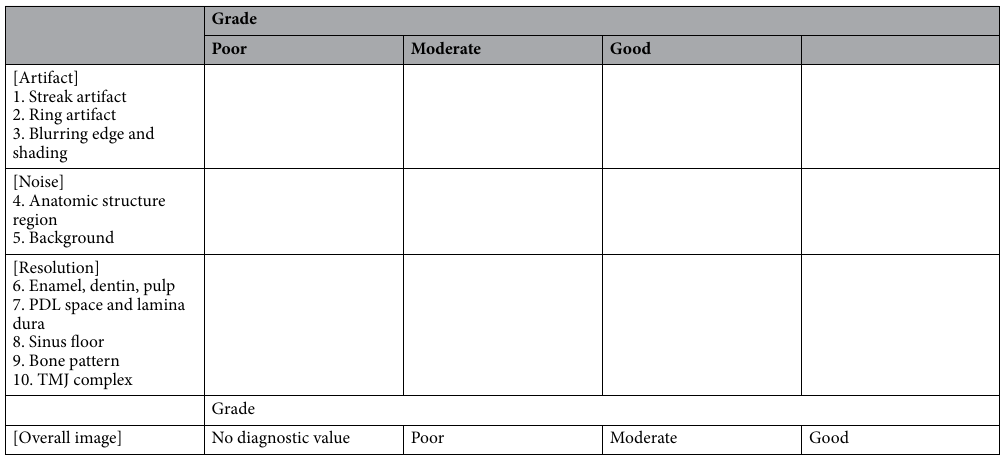
Table 1. Clinical image evaluation chart of CBCT. CBCT, cone-beam computed tomography; PDL, periodontal ligament; TMJ, temporomandibular joint.